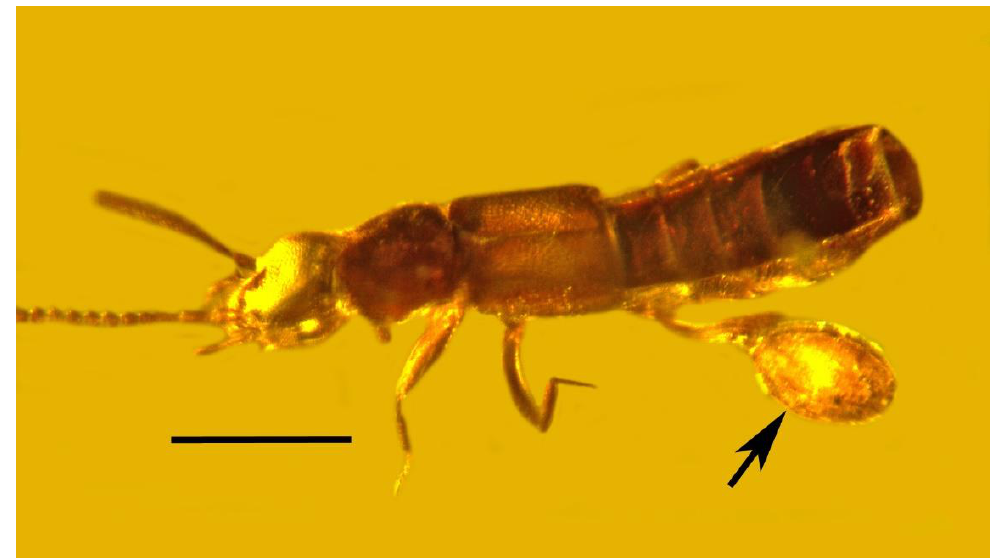
Figure 4. Mite (arrow) (Arachnida: Acari) holding a leg of a staphylinid beetle (Coleoptera: Staphylinidae) by its mouthparts in Dominican amber. Scale bar = 435 µm.